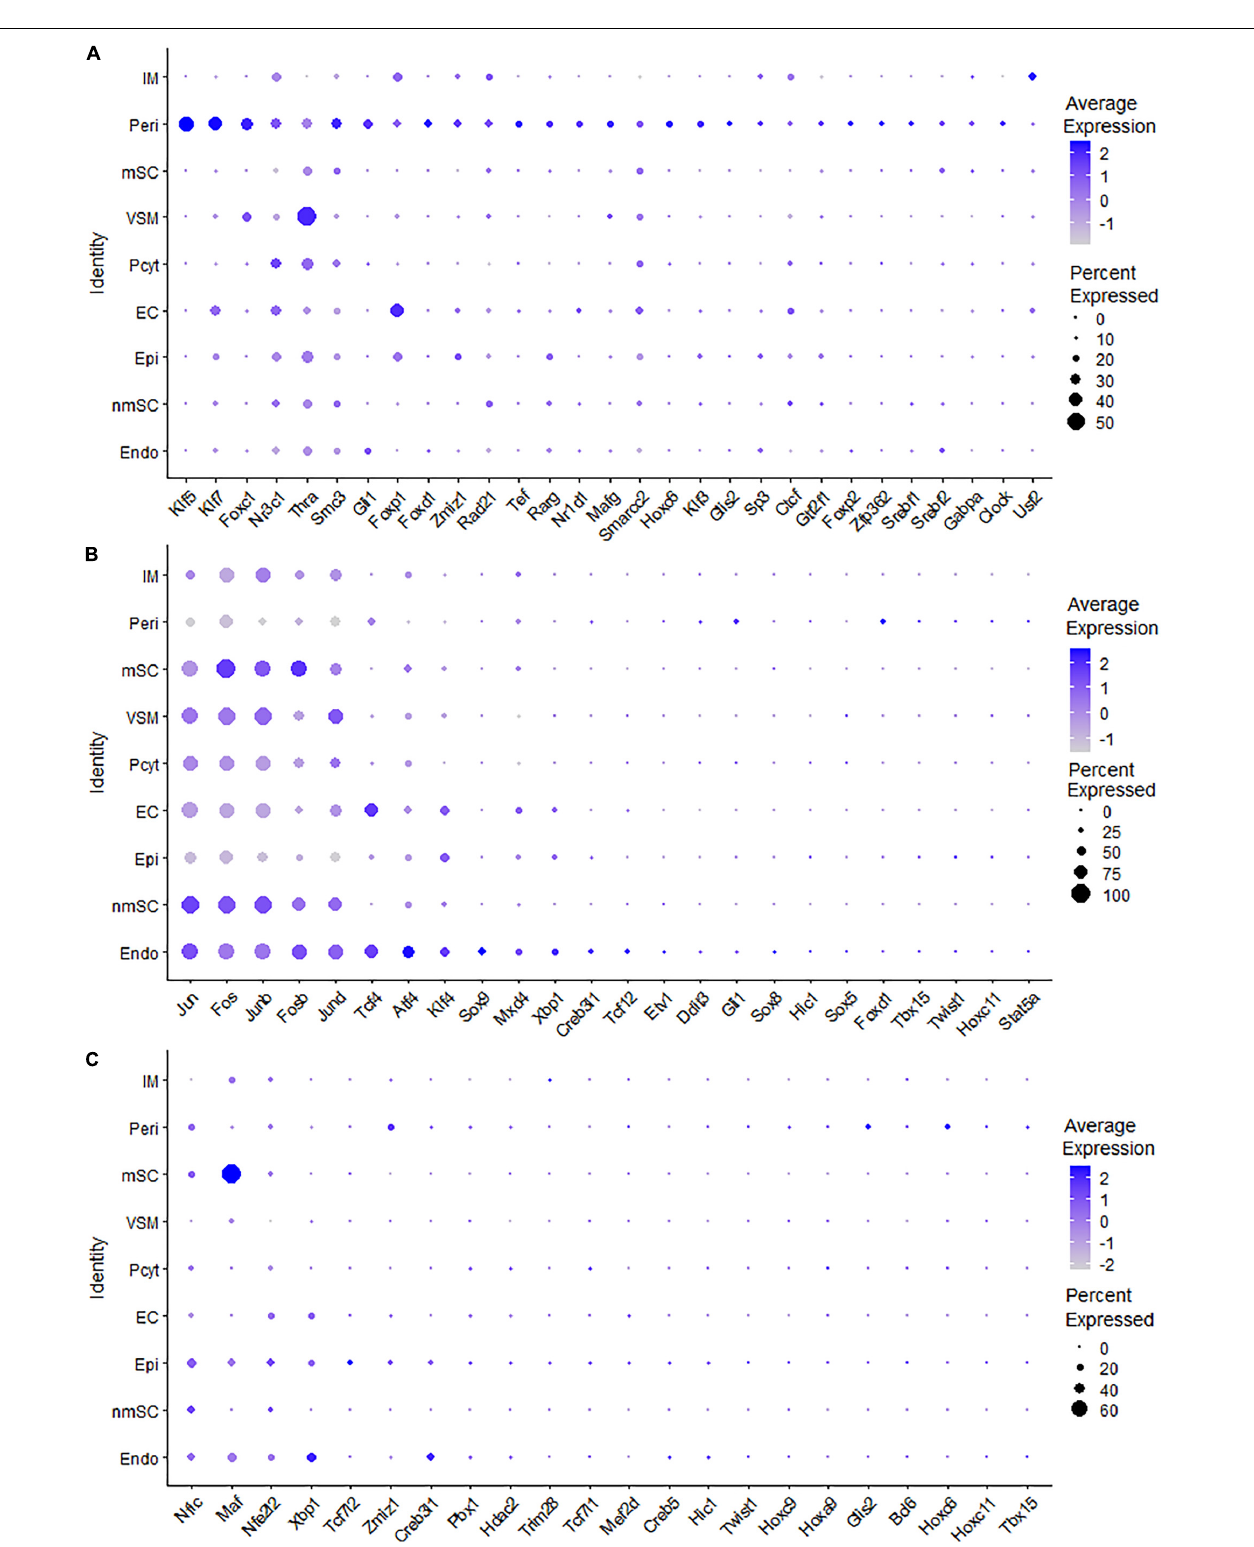
FIGURE 5 | TF expression in fibroblasts. (A) Twenty-nine identified TFs in perineurial fibroblasts expressed in more than 10% of perineurial fibroblast cells. (B) Twenty-four identified TFs in endoneurial fibroblasts expressed in more than 5% of endoneurial fibroblast cells. (C) Twenty-two identified TFs in epineurial fibroblasts expressed in more than 5% of epineurial fibroblast cells.